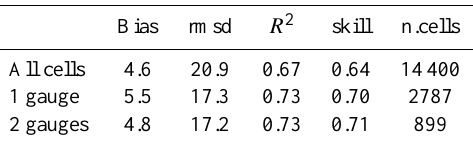
Table 4. EPSAT-SG validation statistic parameters for three datasets with different minimum number of rain-gauges per grid- cell.